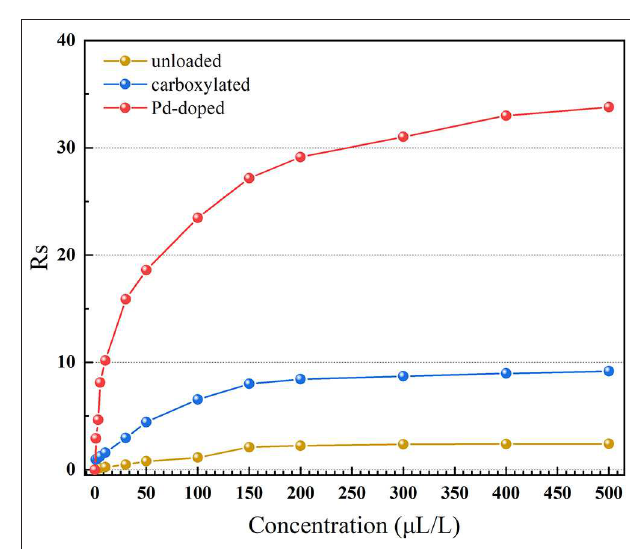
FIGURE 8 | The concentration characteristics of the unloaded, carboxylated, and 3.07 wt% Pd-doped SWCNTs-based gas sensors.